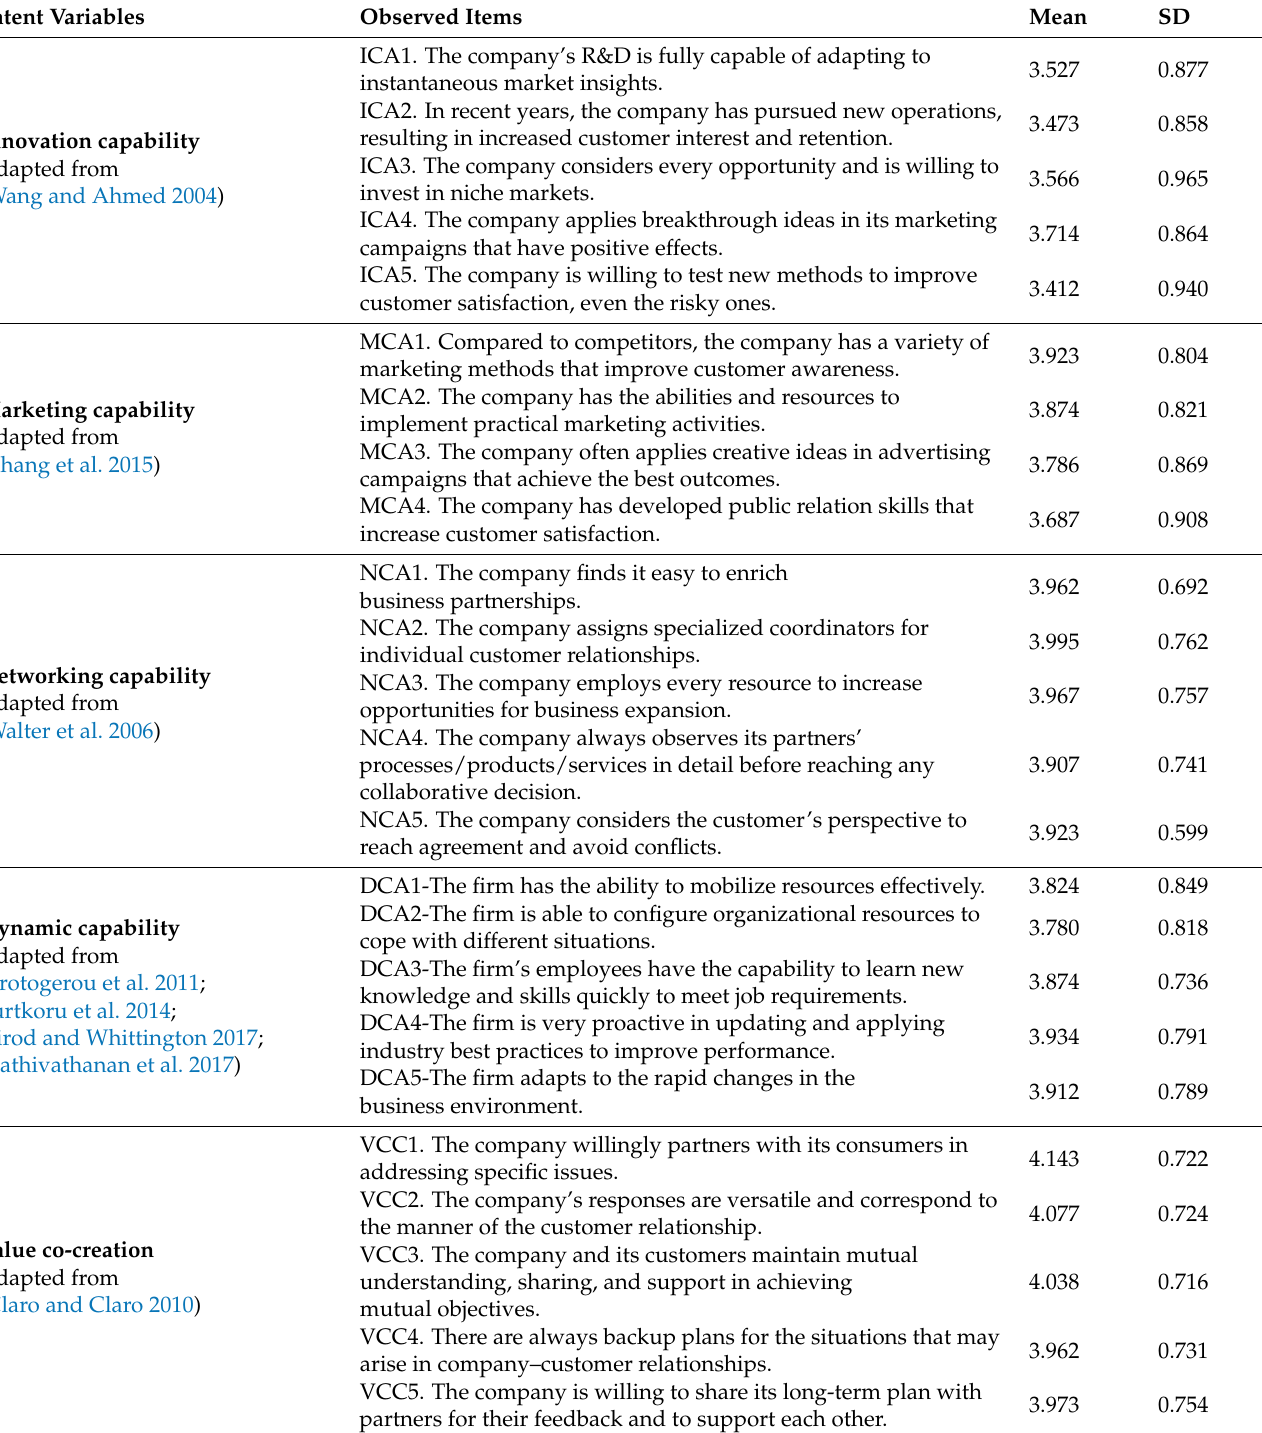
Table 1. Questionnaire construction and latent